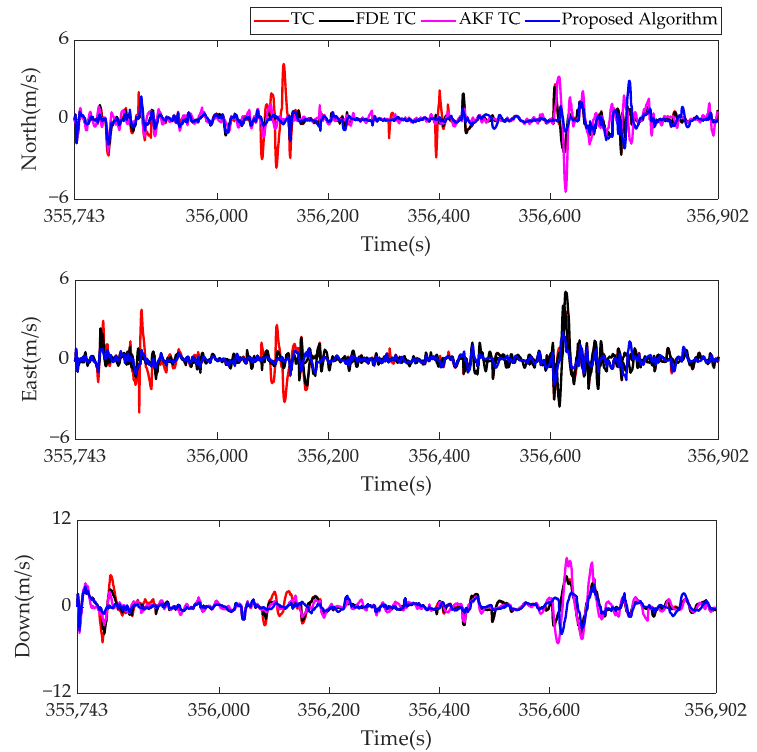
Figure 9. The velocity error of TC, FDE TC, AKF TC, and the proposed algorithm in field test.